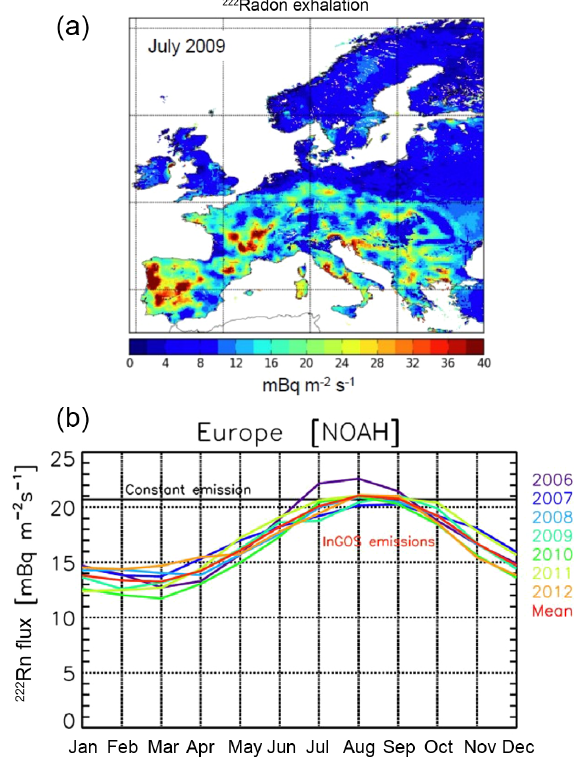
Figure 2. Radon ( 222 Rn) emissions used for the model simula- tions, (a) spatial distribution of InGOS emissions over Europe dur- ing July 2009, (b) seasonal and inter-annual variations of InGOS emissions (in different colours for different years; mean in red) and the commonly used constant emissions (black). The mean seasonal variations are averaged over the geographic domain between 10 ◦ W and 30 ◦ E longitude and between 35 and 70 ◦ N